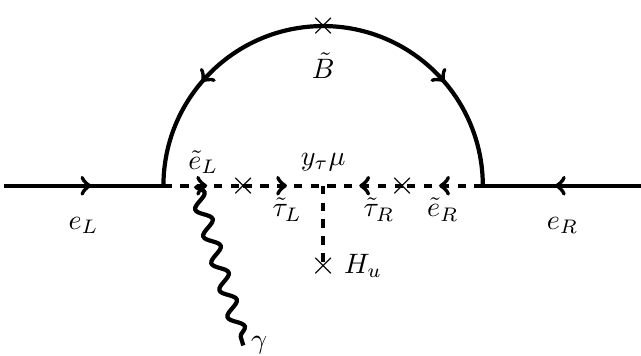
Figure 9. One-loop diagrams contributing to the electron EDM in the presence of flavor violation, proportional to the flavor-violating parameters δ LL violating phases when arising from gravity